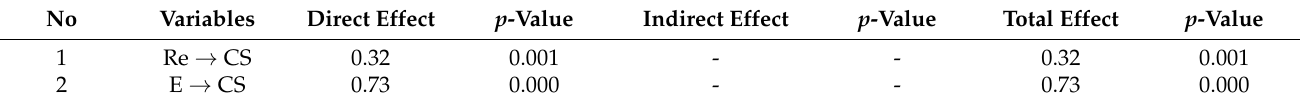
Table 4. Relationship Between the Two